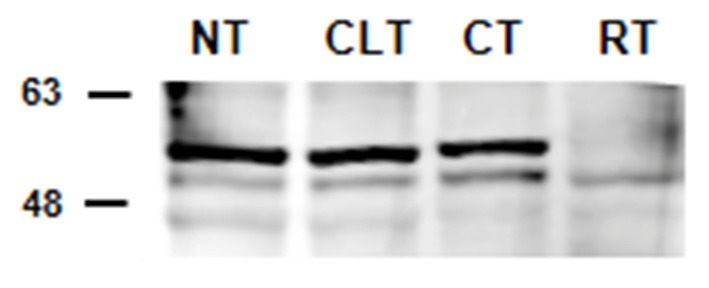
Detection by western blot analysis of ARO in the normal, contralateral, and cryptic male gonads of dogs. ARO was detected in the normal (NT), contralateral (CLT), and cryptic (CT) testis. Samples from rat testis (RT) were also examined as positive controls. In all the examined tissues, ARO appears as 2 bands, one at ~49 kDa and another ~51–53 kDa. This image is representative of three different experiments.